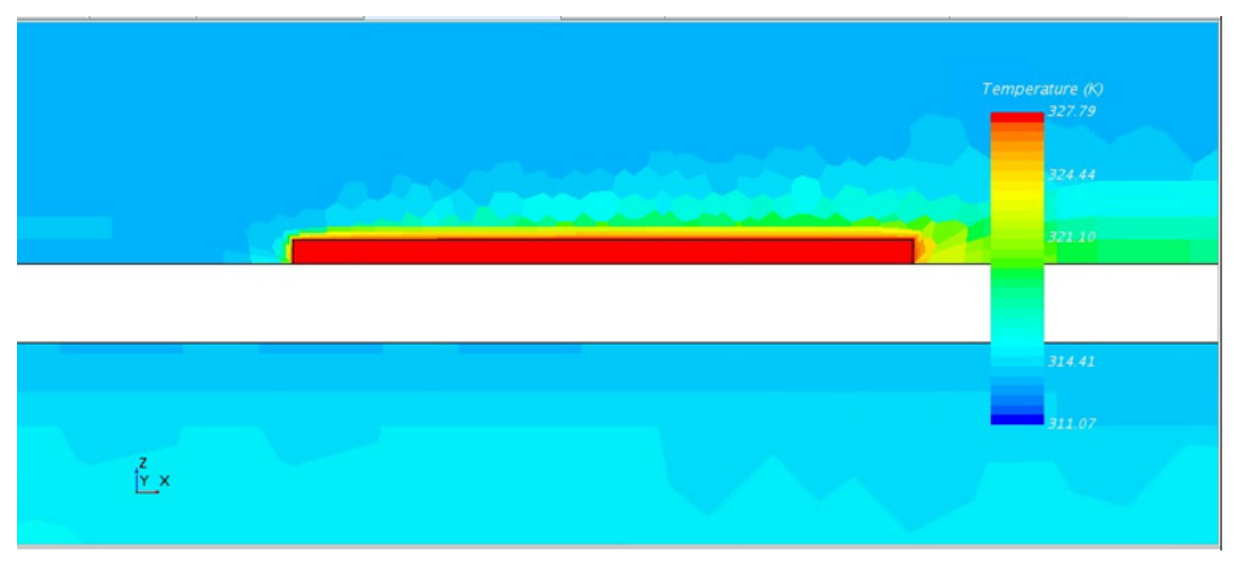
Figure 9. The temperature of the sample.